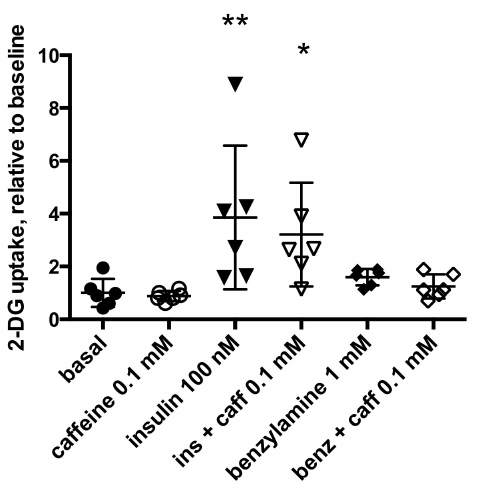
Figure 5. Influence of caffeine on [ 3 H]-2-DG uptake by human adipocytes under basal conditions and when activated by insulin or benzylamine. Each agent was incubated 45 min with human adipocytes prior the determination of [ 3 H]-2-DG uptake on a 10-min period. Each column is mean ± SEM of six individual preparations. Significant differences from basal 2-DG uptake (closed circles) at: * p < 0.05, ** p < 0.01. No significant effect of 0.1 mM caffeine (caff, open symbols) was found for each of the conditions tested: basal, insulin (ins), or benzylamine